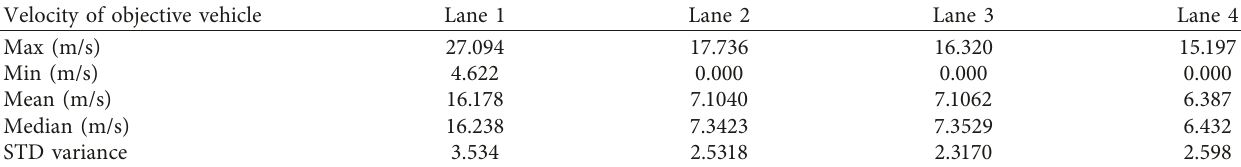
Table 2: Detailed information on the velocity of objective vehicles in different lanes.